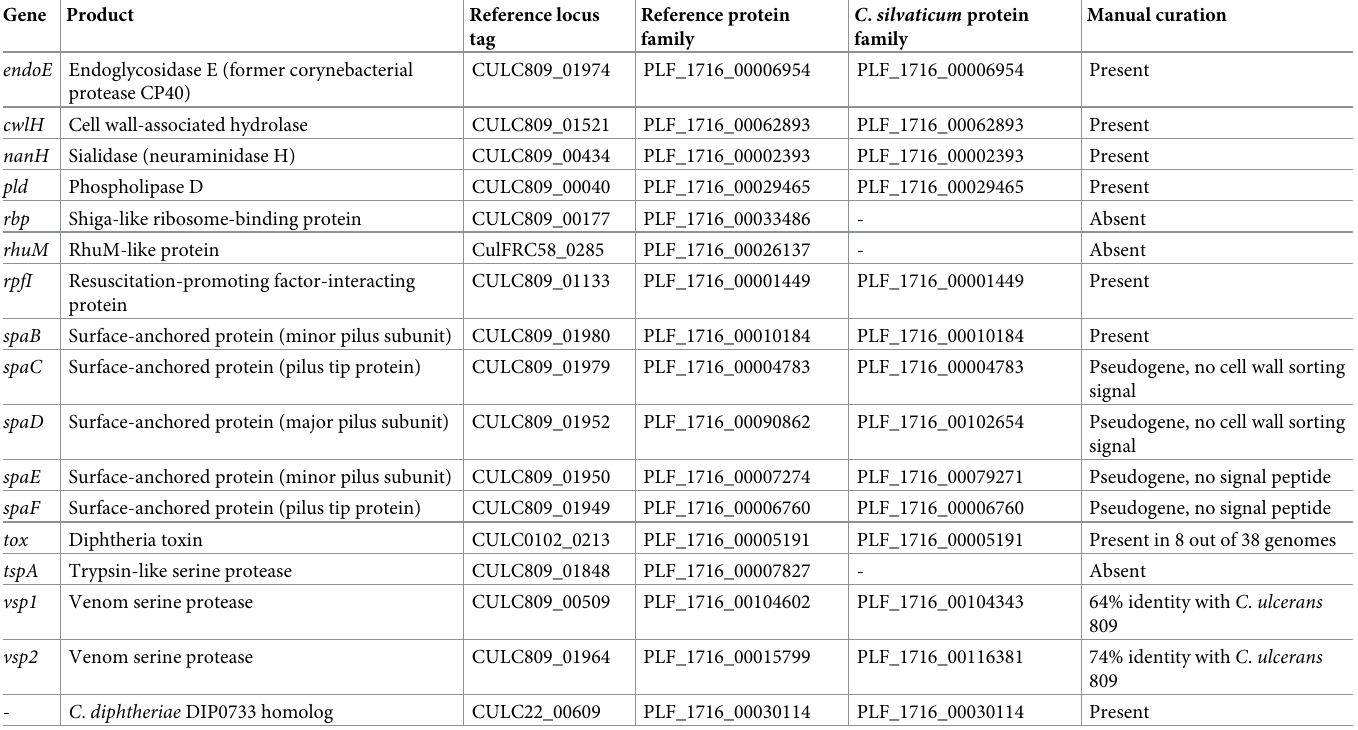
Table 1. Presence of 16 known niche and virulence factors of Corynebacterium in C . silvaticum .